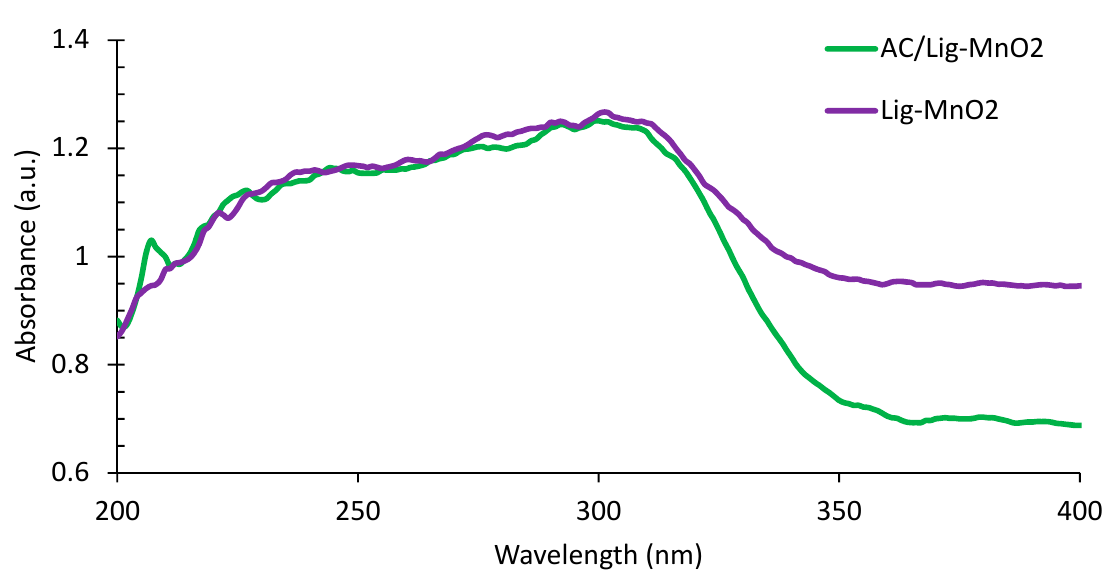
Figure 4. UV-vis spectroscopy of AC/Lig-MnO 2 and Lig-MnO 2.